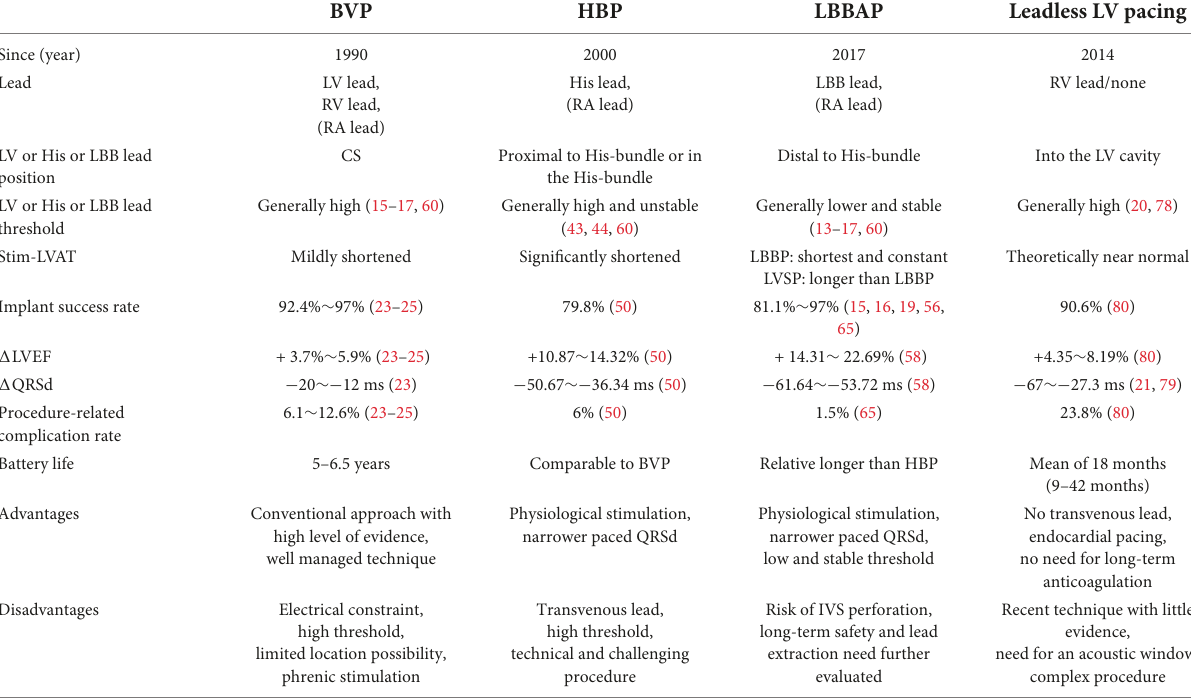
TABLE 1 Comparison of BVP, HBP, LBBAP, and leadless LV